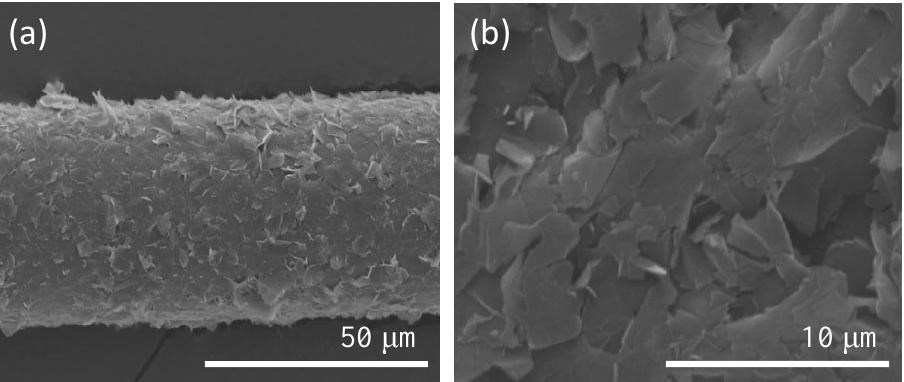
Figure 5 . Cont. Figure 5. Cont